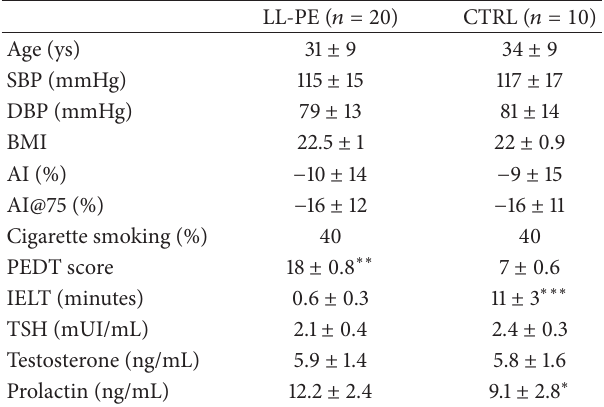
Table 1: Demographic characteristics at